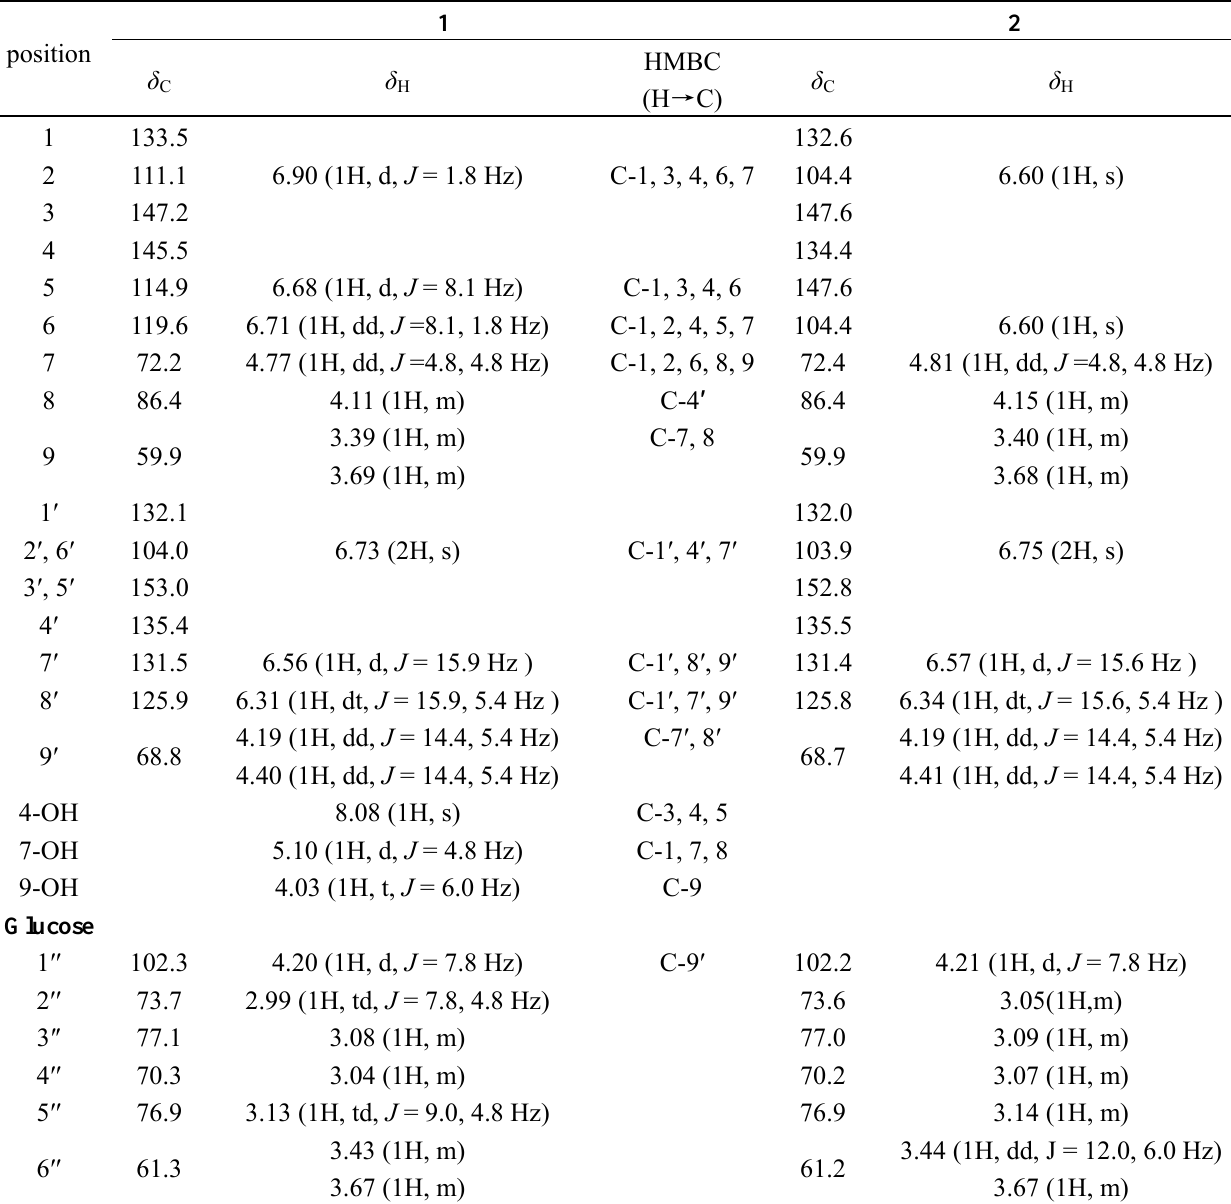
Table 1. 13 C-NMR (150 MHz), 1 H-NMR (600 MHz) spectral data of compound 1 , 2